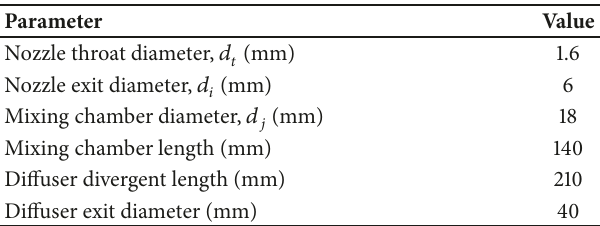
Table 3: Ejector characteristics